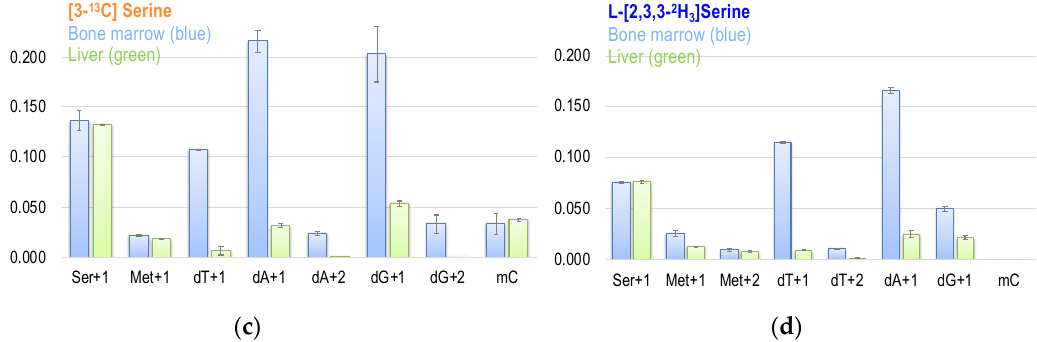
Figure 5. ( a ) The metabolic fate of serine 3-carbon was assessed by labeling experiments using [3- 13 C]serine as the tracer. The 3-carbon of serine serves as the major 1C source in the folate cycle that can subsequently be used for methionine synthesis via folate-dependent homocysteine remethylation, and for purine and dTMP syntheses. ( b ) Enrichments in target metabolite serine, methionine, dTMP, and deoxy-methylcytosine (mC) in the bone marrow and the liver from mice received [2- 13 C]glycine tracer for six days. These approaches enable a better understanding of the utilization of 1C moiety generated directly from mitochondrial GCS in vivo. ( c , d ) Enrichments in target metabolite serine, methionine, dTMP, purines, and deoxy-methylcytosine (mC) in the bone marrow and the liver from mice received [3- 13 C]serine ( c ) and [2,3,3- 2 H 3 ]-serine ( d ). The 3-carbon of serine is marked in orange with a * and the recycled serine 2-carbon from the GCS is marked with a *.